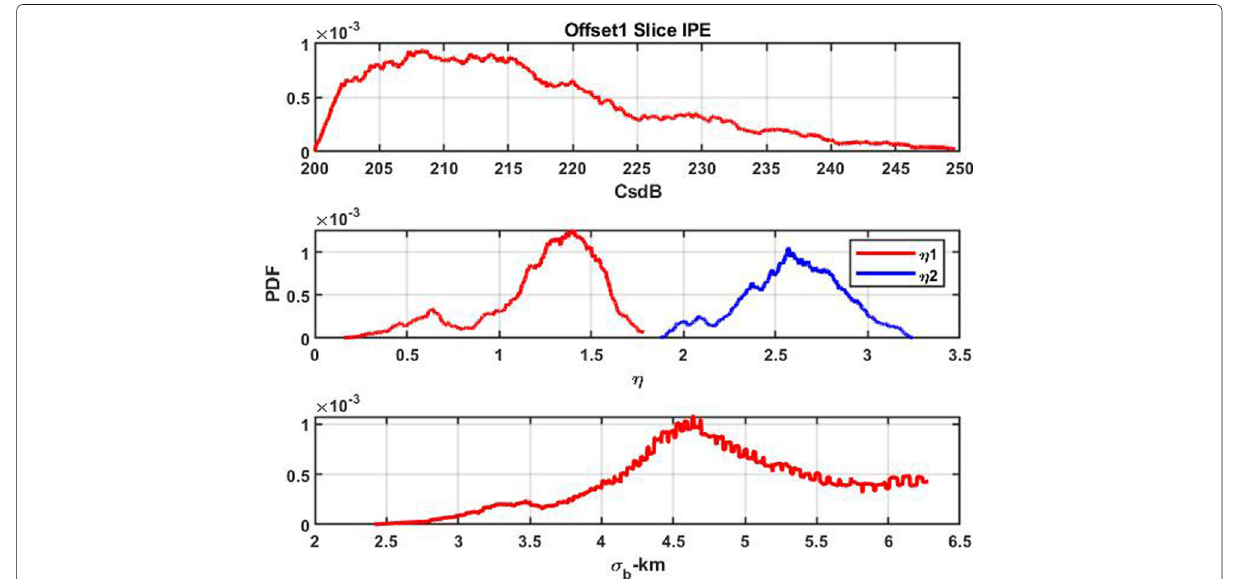
Fig. 13 Probability distributions of offset1 plane stochastic structure